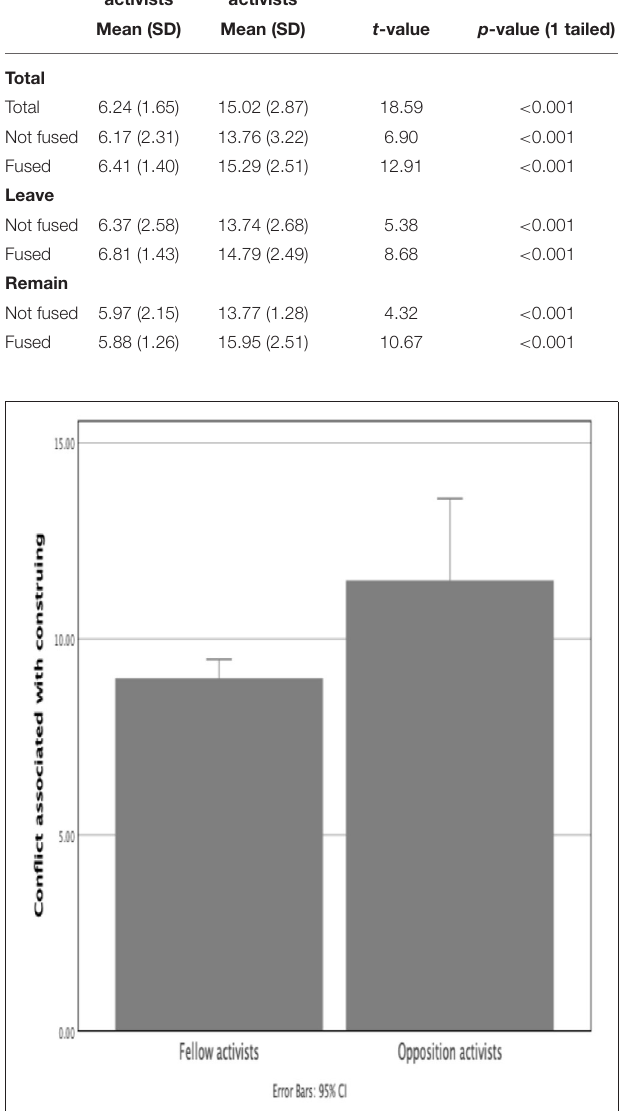
FIGURE 8 | Amount of conflict associated with the construing of fellow and opposition activists. A lesser amount indicates a clearer and less conflicted way of